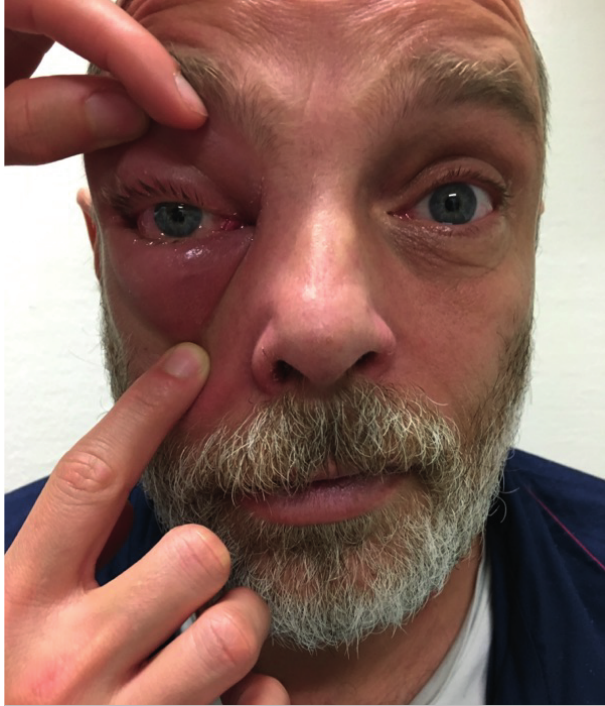
Figure 1. Preoperative photo of a patient treated at our department for a medially placed SPOA.